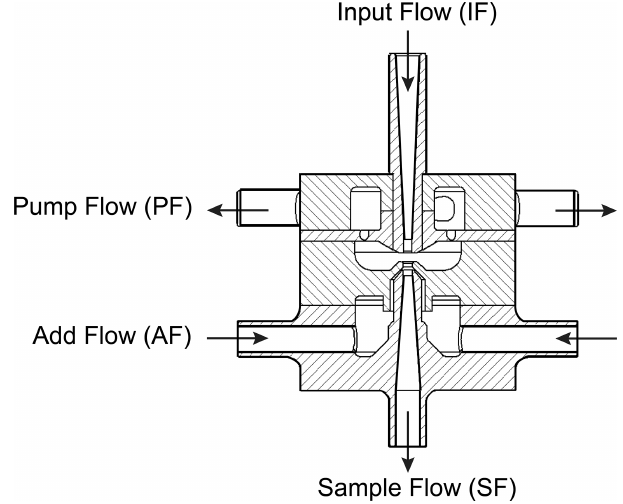
Figure 1. Cross-sectional view of the 3D-printed SPIDER PCVI with flows labeled. The 3D-printed PCVI features the improved conical input nozzle suggested by Kulkarni et al. (2011); otherwise, the design is the same as considered by Kulkarni et al.